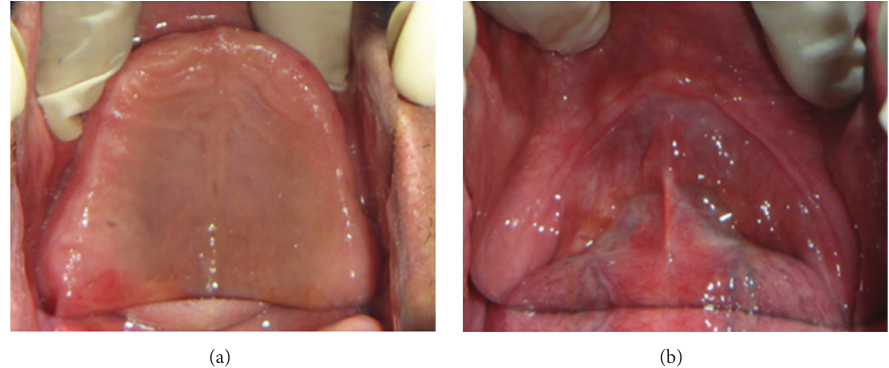
Figure 5: Maxillary arch and mandibular severely resorbed irregular residual ridge with elevations and depressions.